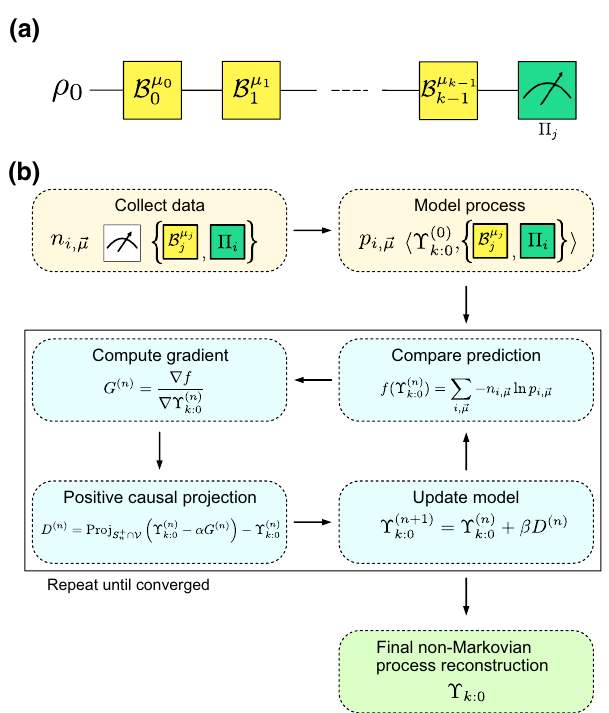
FIG. 3. (a) The circuit structure for PTT. An arbitrary state is fed in, the experimenter acts with all combinations of differ- ent basis elements at different times, and a final measurement is recorded. (b) The logical flow of PGDB in the context of our MLE-PTT procedure. We maximize the likelihood of the model through iterative gradient descent and the physical projection of Sec. III A until some convergence condition is achieved. Full details of the algorithm are shown in Appendix